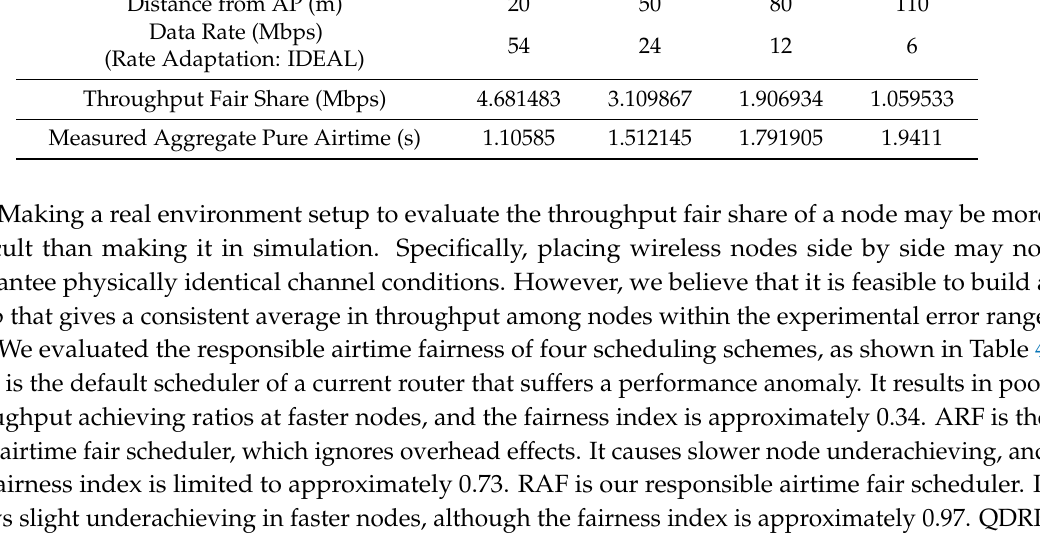
Figure 4. Basic Network Topology in Experiments.